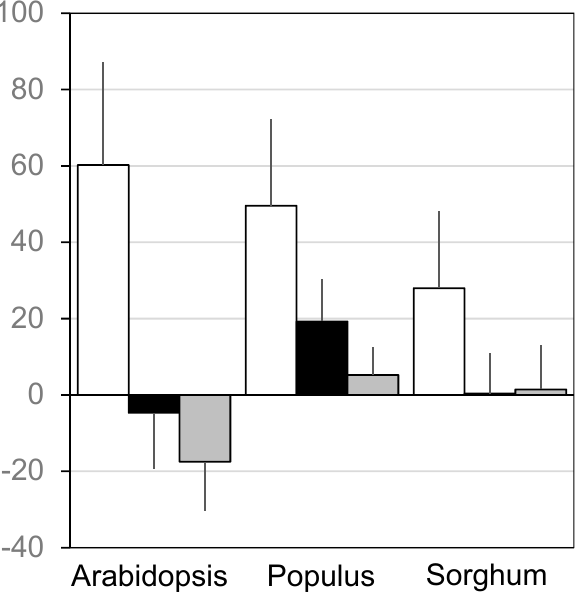
Figure 2. Average haplotype capture in subsets assembled using genomewide single nucleotide polymorphism (SNP), geographic, and environmental data. Y-axis measures relative enrichment, zero is haplotypic diversity of random subsets. Error bar shows one standard deviation from the mean. White bars, genomewide SNP data; black, geographic data; grey, environmental data. All pairwise comparisons within taxa differ significantly ( t -test, p < 2E − 16).